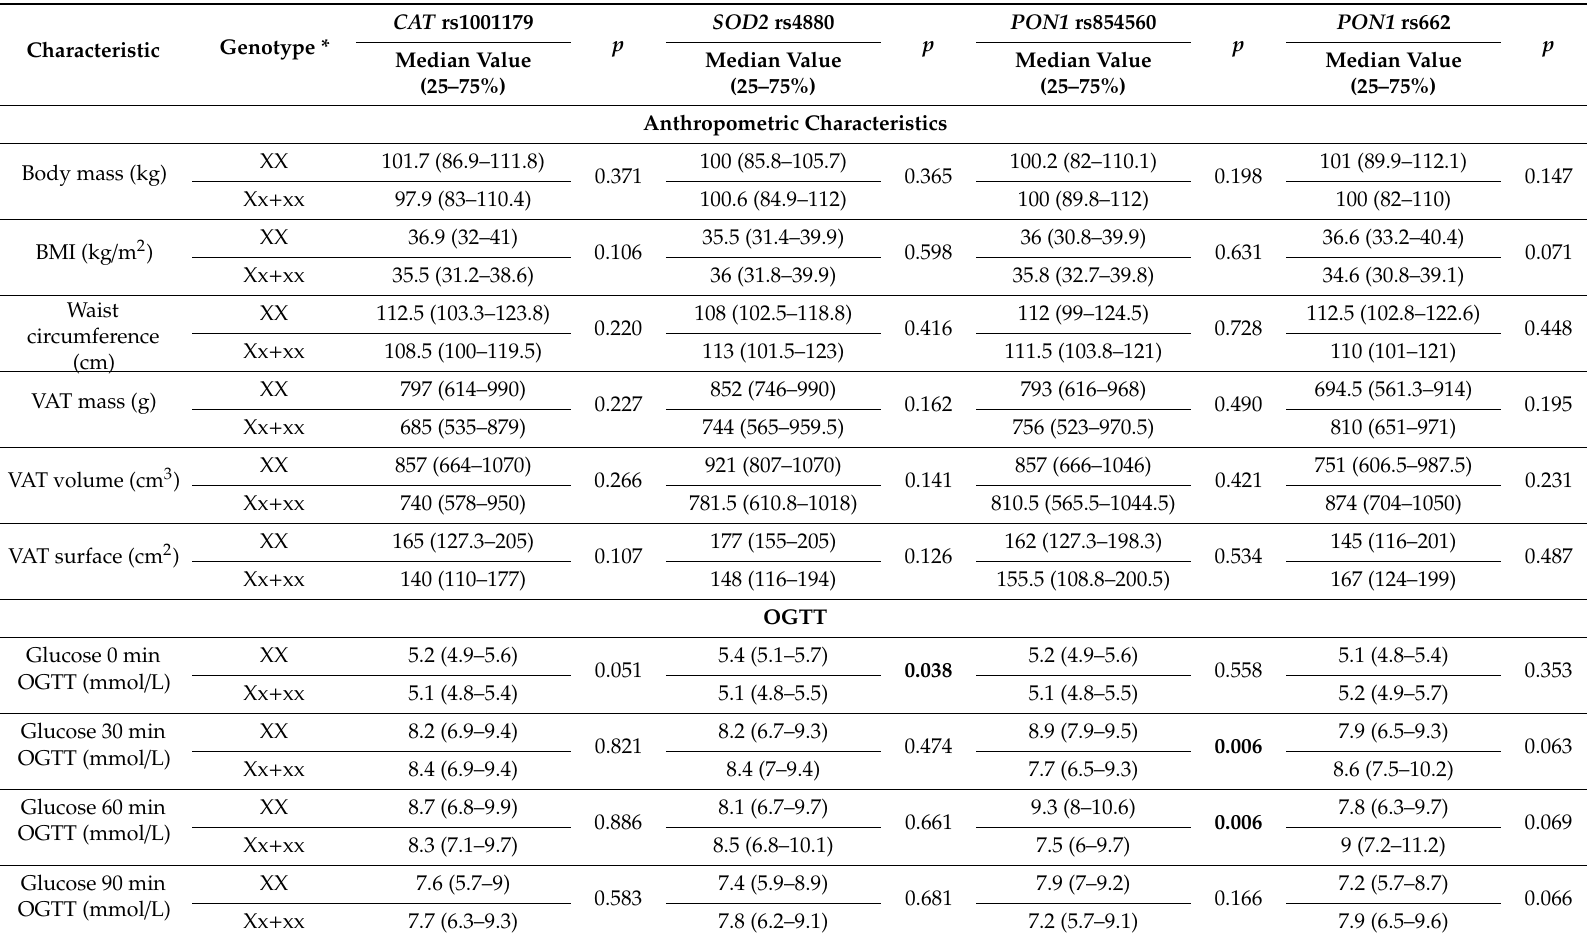
Table 4. E ff ects of polymorphisms in genes related to oxidative stress (OS) on PCOS patients’ clinical